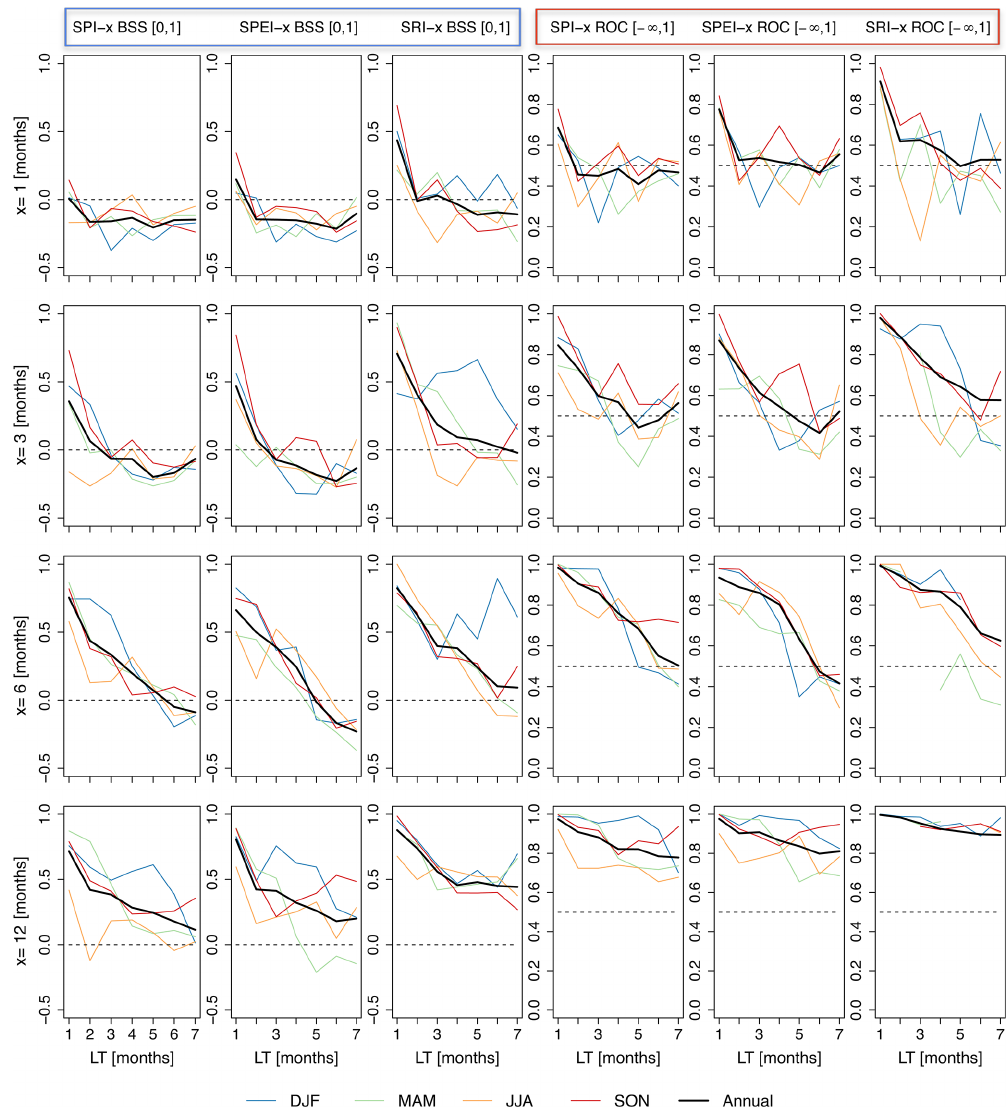
Figure 2. Skill scores of re-forecast drought hazard indices (SPI-x, SPEI-x, and SRI-x) for 7-month lead times (LTs) in Germany for the period 2002–2010 (median of 15 ensemble members). The four different rows of graphs represent four different accumulation periods ( x = 1, 3, 6, and 12 months). The black dashed line indicates the threshold (BSS = 0; ROC = 0.5). The first three columns show the BSS for the three different drought indices (indicated by a blue box at the top). The last three columns are for ROC (indicated by a red box at the